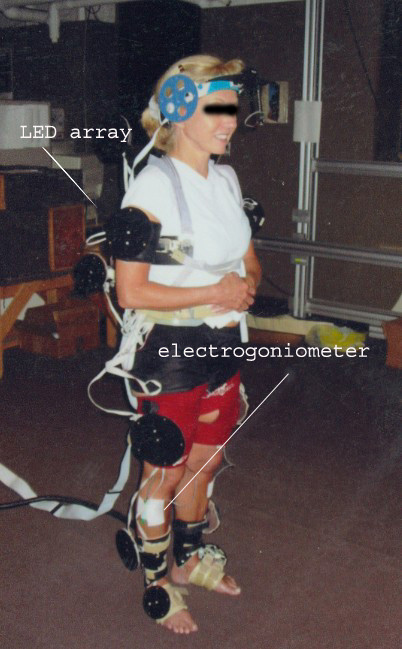
Photograph of a subject being tested in the MGH Biomotion Laboratory with both the IDEEA system and LED arrays in place.